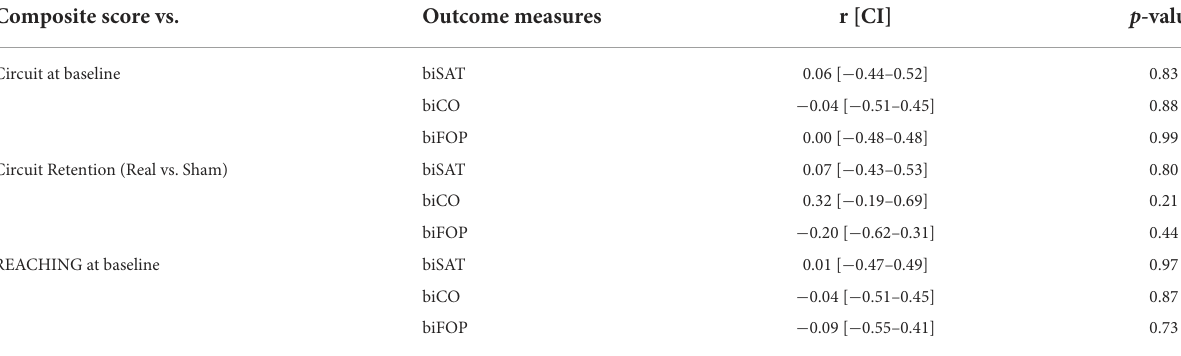
TABLE 6 Correlations with the composite score in patients with stroke. Composite score